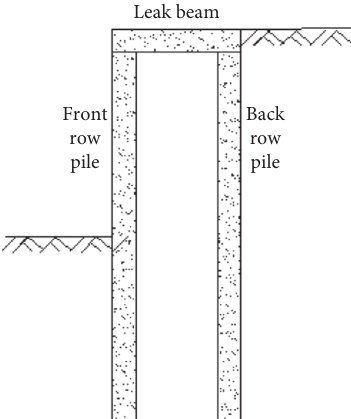
Figure 1: Schematic diagram of traditional double-row pile sup- port structure.